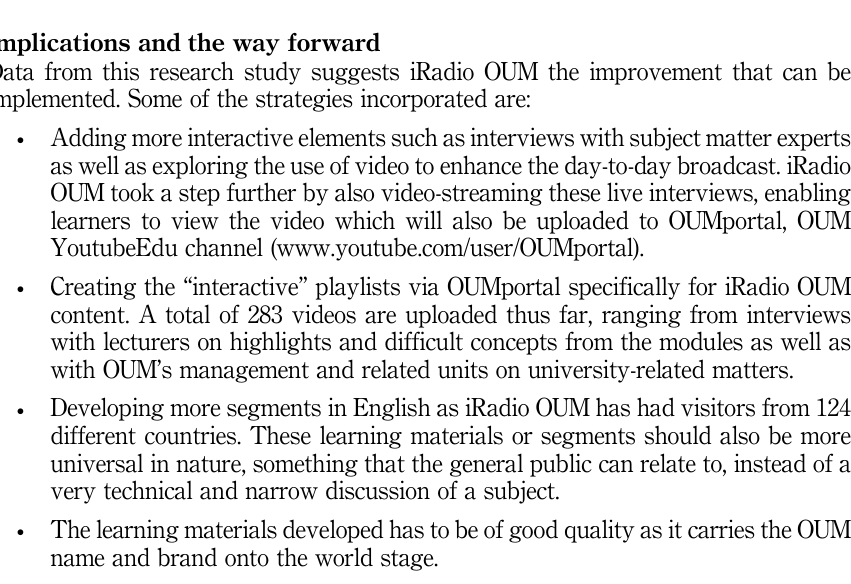
Figure 7. Total monthly